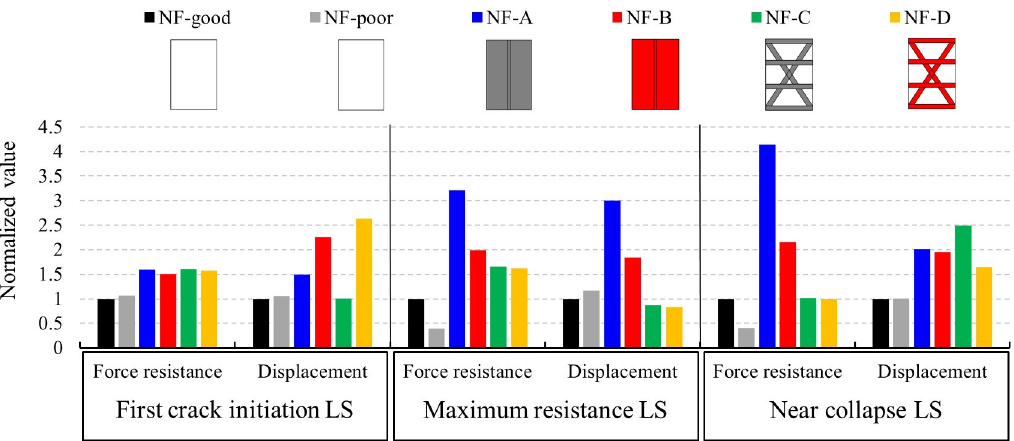
Figure 10. Efficiency of tested strengthening systems in respect to observed limit states considering both out-of-plane force resistance and corresponding